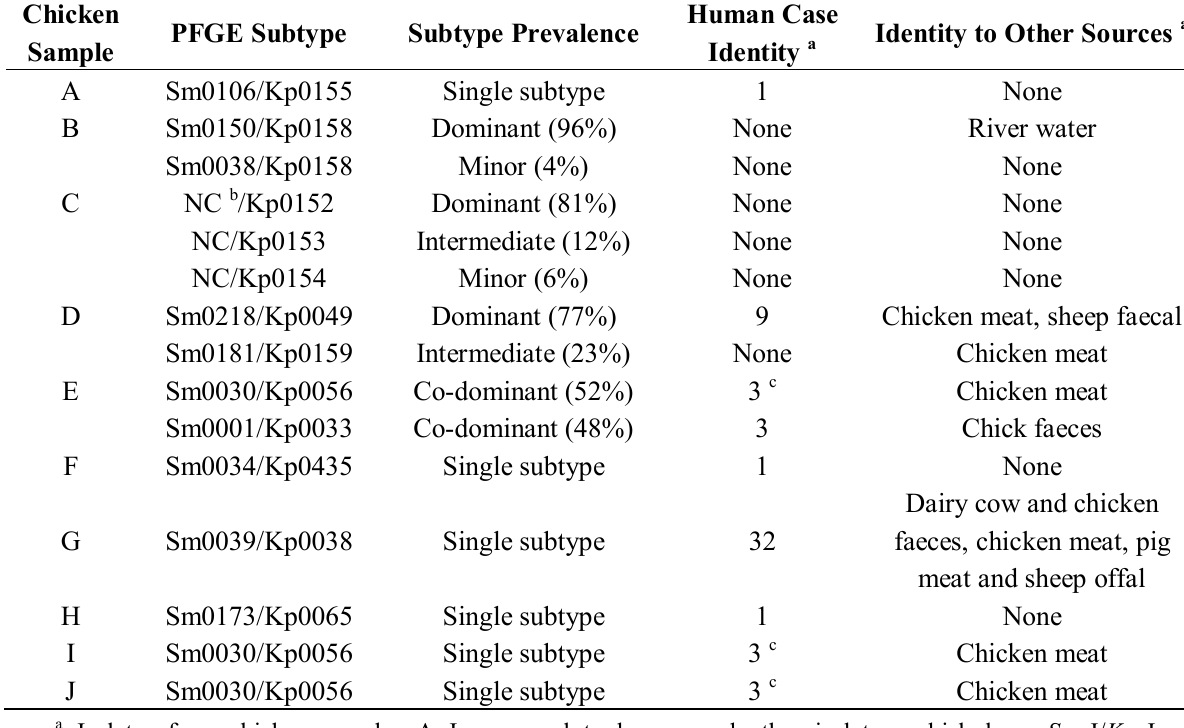
Table 1. Campylobacter jejuni subtypes isolated from chicken